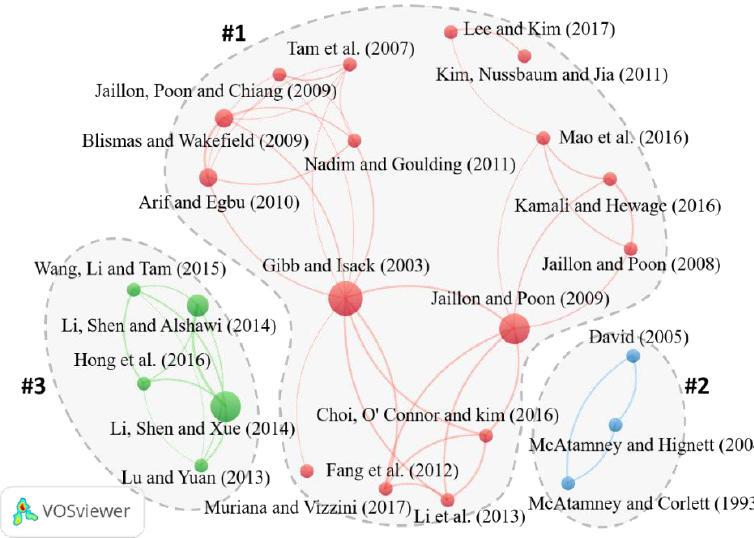
Figure 4. Document co-citation network.